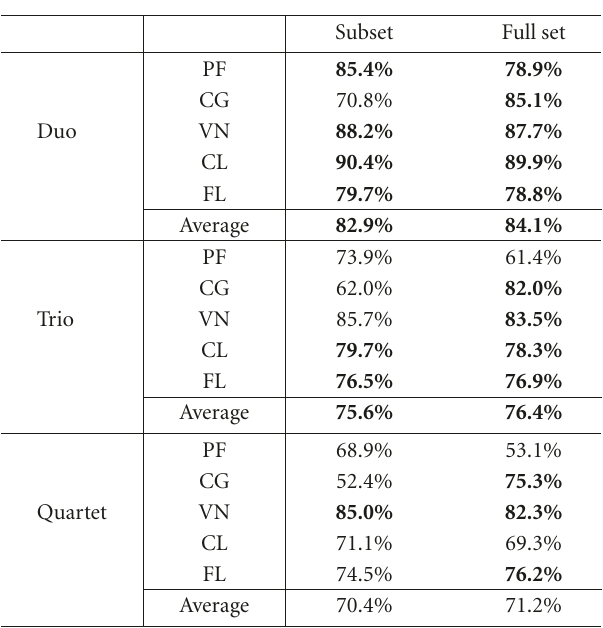
Table 10: Comparison of templates whose instrument combina- tions were reduced (subset) and not reduced (full set).